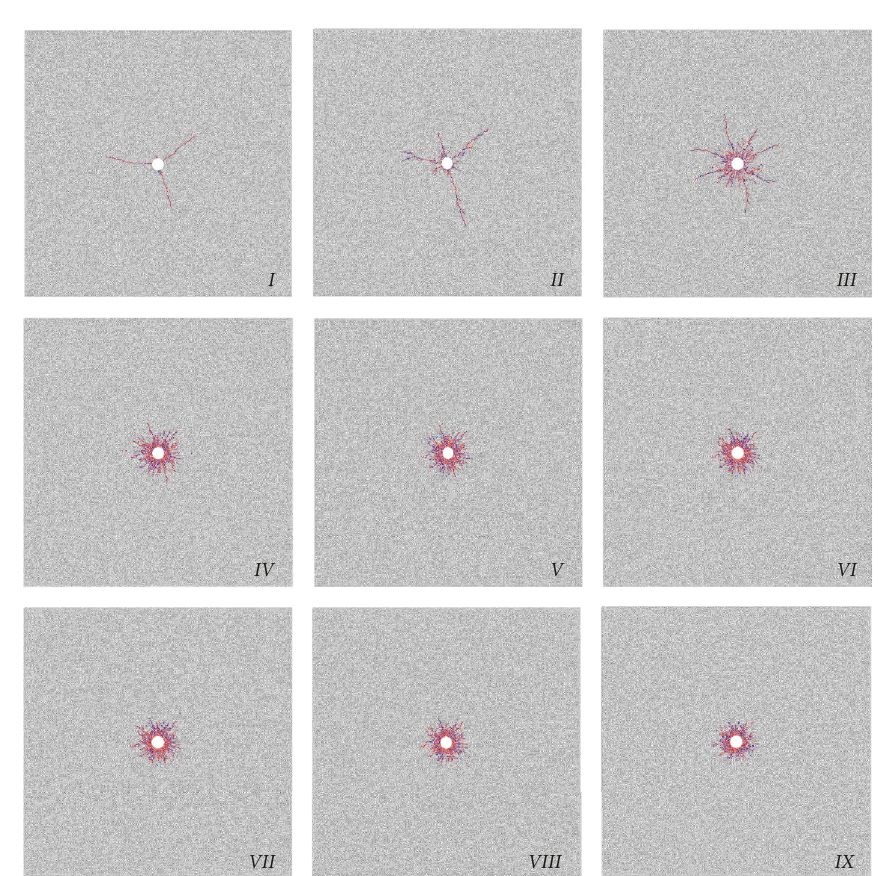
Figure 8: Crack propagation under a